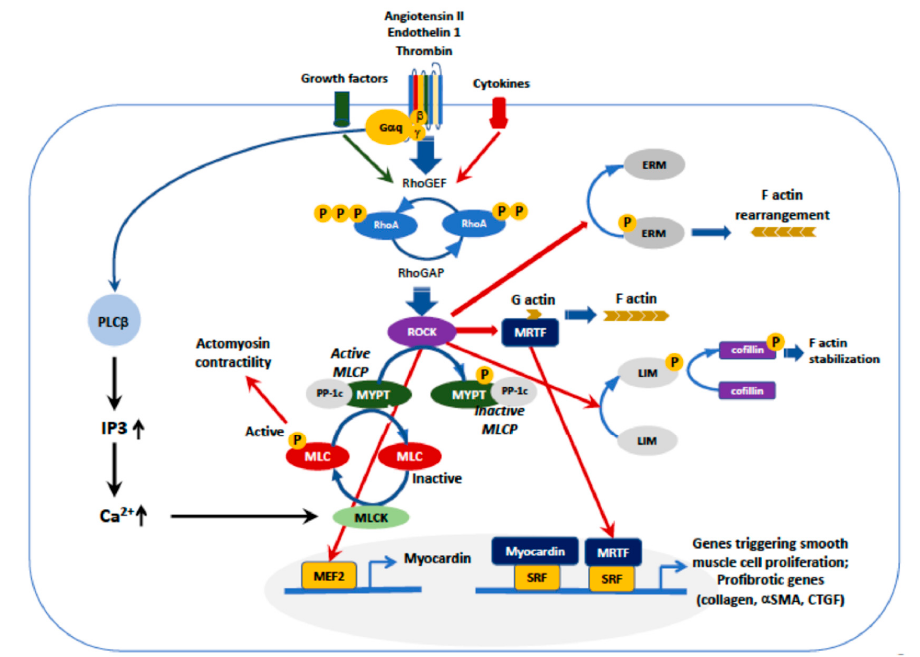
Figure 2. Upstream and downstream regulation of ROCK. Activation of G protein-coupled receptors, e.g., AT1 or ET-1, or receptors for cytokines or other growth factors, activate RhoGEF that, in turn phosphorylates RhoA/ROCK. The major ROCK downstream pathways are (1) myosin light chain phosphatase (MLCP)/MLC, (2) ezrin, radixin and moesin (ERM), (3) myocardin and serum response factor (SRF), (4) LIM (Lin-11, Isl-1,Mec-3))/cofilin, (5) assembly of F-actin with release of myocardin-related transcription factor (MRTF). The assembly of F-actin enables MRTF to dissociate from G-actin, leading to MRTF nuclear translocation and binding to SRF, which triggers transcription of genes involved in cardiovascular remodeling. However, all pathways concur to the development of smooth muscle cell proliferation, transition of myocytes into myofibroblasts and fibrosis, or stress fibers formation.